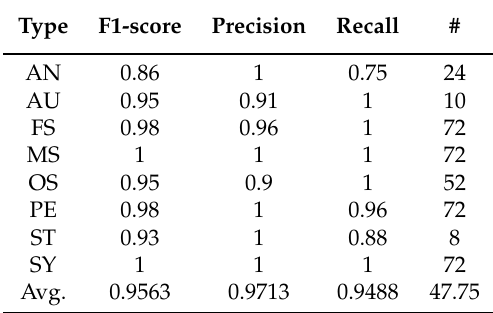
Table 7. Neural architecture search (NAS) model 1 (the original data).